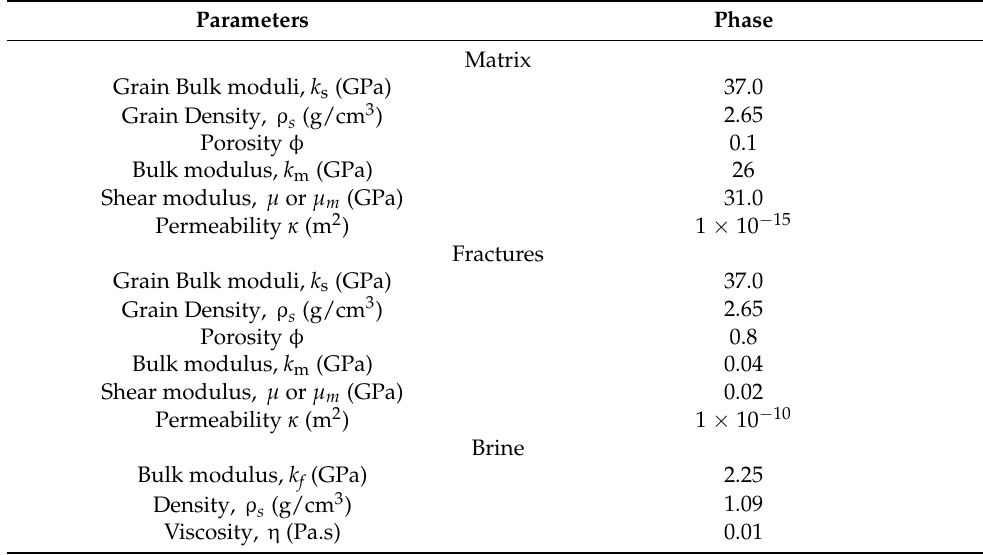
Table 1. Simulation parameters for multi-dimensional cracked